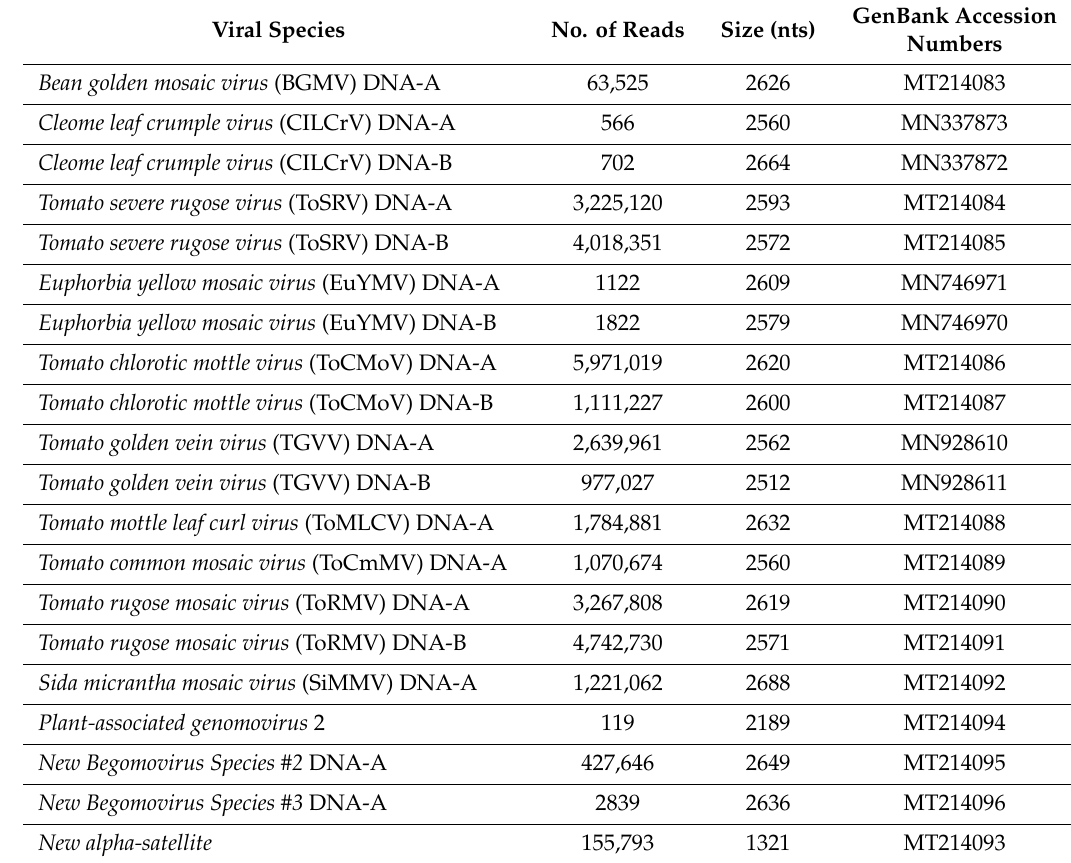
Table 4. Viral circular, single-stranded DNA species (and their corresponding GenBank accessions) detected after Illumina Hiseq sequencing in the pool of tomato DNA samples lacking the Ty -1 gene. Viral Species